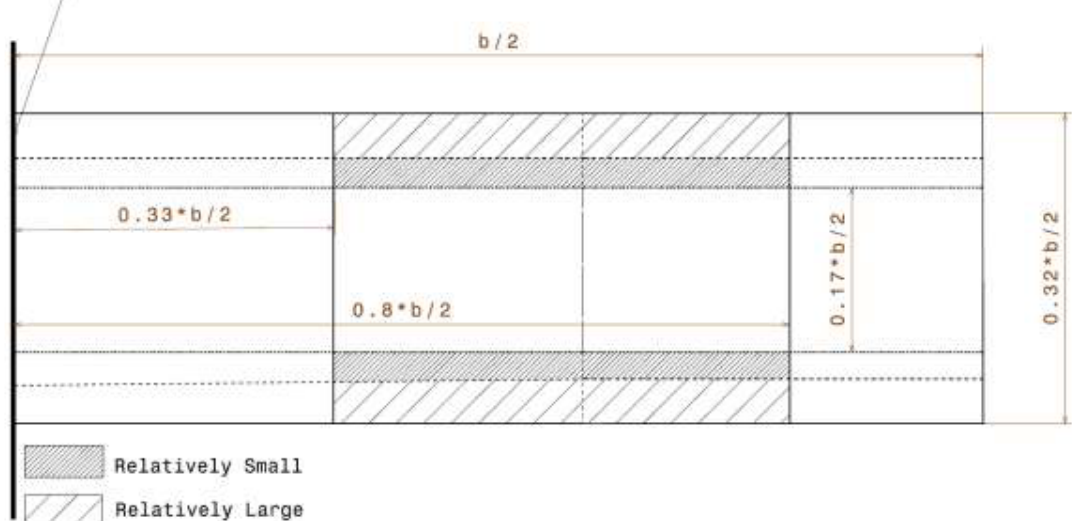
Figure 15. Non-dimensional estimation range of the FW max chord max, and its location through the wing semi-span.